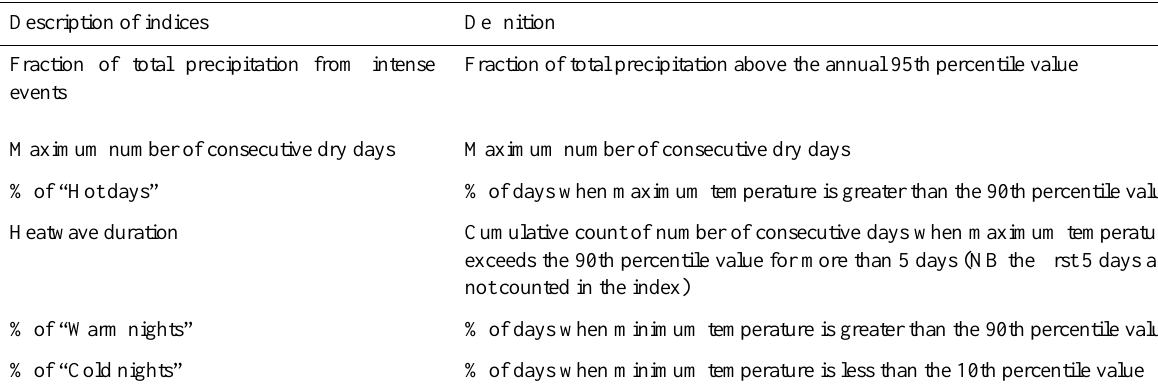
Table 2. Indices of extremes used.